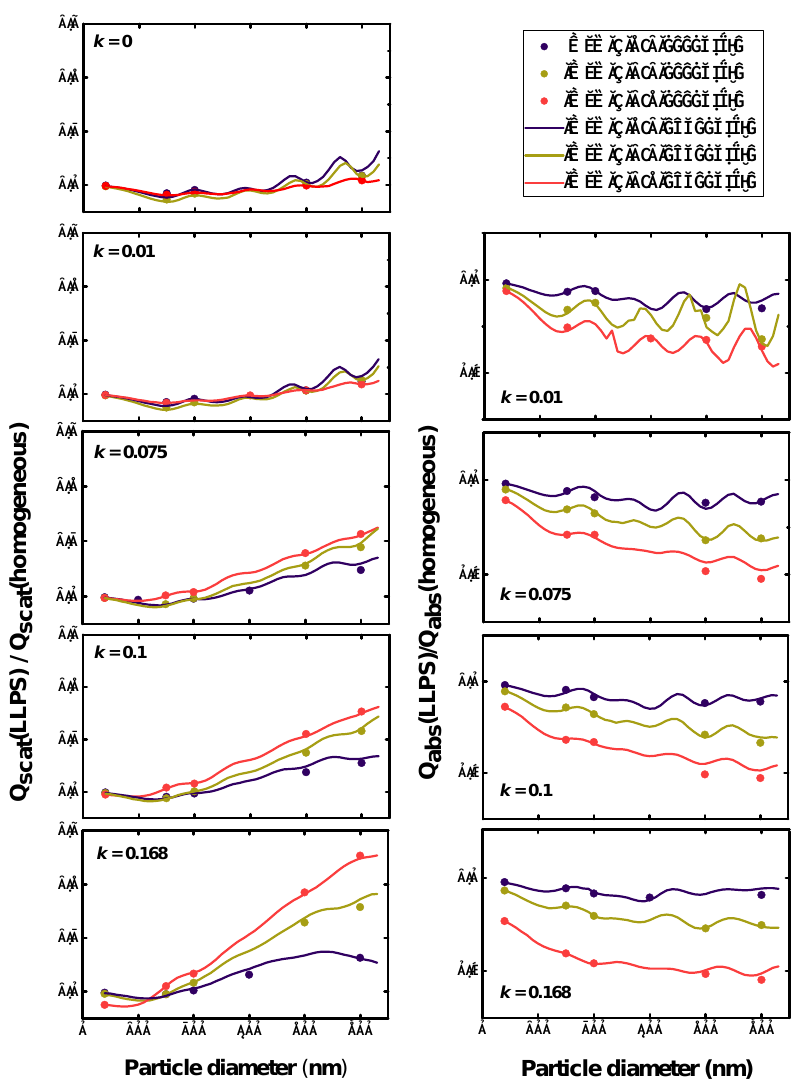
Figure 6. Left column: ratio of Q scat for LLPS morphology over homogenous morphology as a function of particle diameter for OIR = 1 : 4, 1 : 1 and 4 : 1, with increasing k from top to bottom, k = 0, 0.01, 0.075, 0.1 and 0.168. Right column: corresponding absorption efficiency ratios. Dots represent calculations with random orientation of an eccentric core shell for the phase-separated particles; lines are calculations for the corresponding symmetric core-shell morphology (we used volume mixing to calculate refractive indices; see Tables A1 and